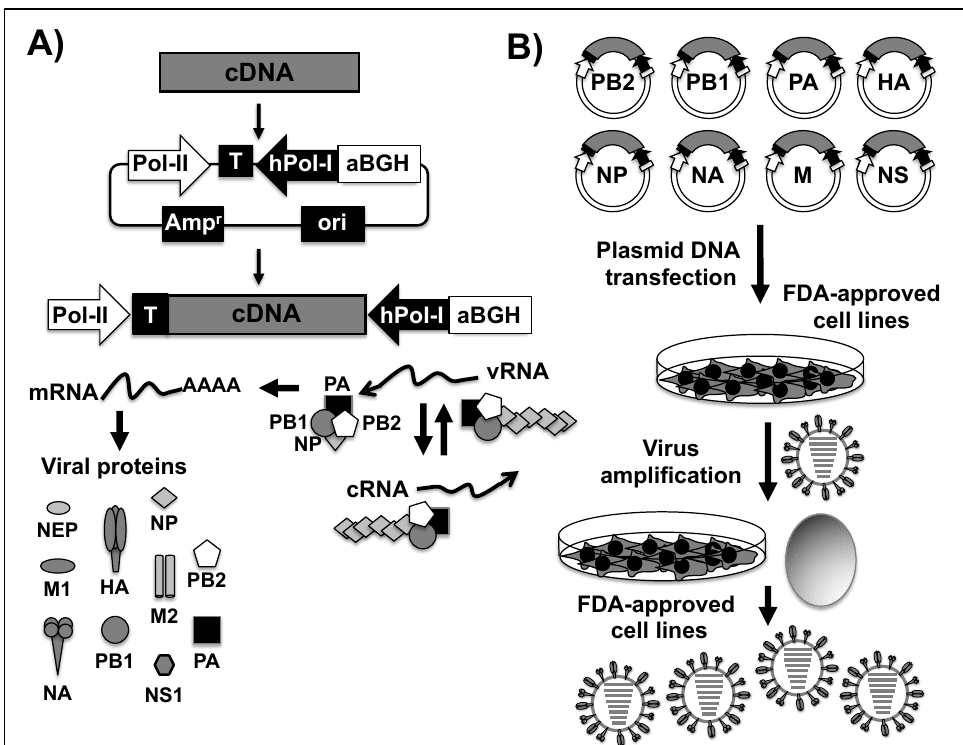
Figure 4. IAV vRNA cloning into ambisense/bidirectional plasmids for the generation of recombinant viruses using plasmid-based reverse genetic approaches. ( A ) Schematic representation of the